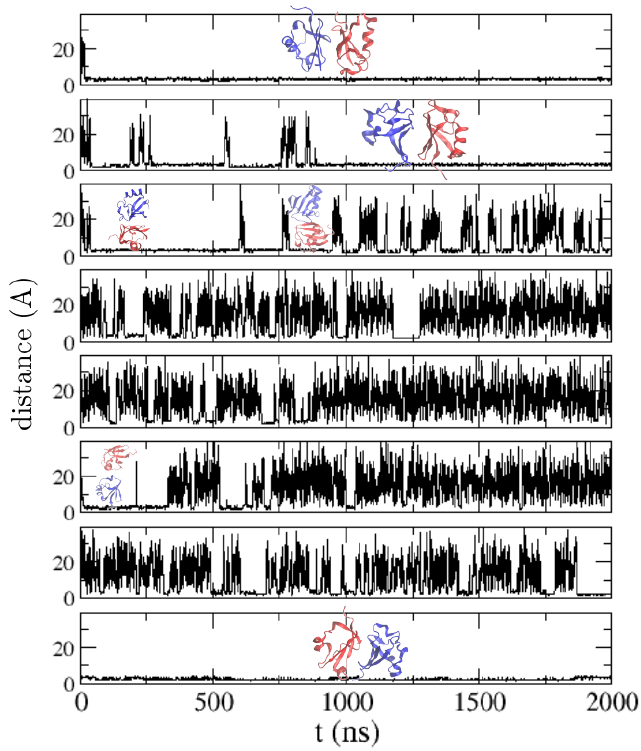
Figure 5. Minimum distance between two ubiquitin molecules in molecular dynamics simulations of a solution of ubiquitin at a concentration of 5 mM with the PACSAB model in the 8 trajectories produced. The most stable bound configurations found during the simulations are shown.